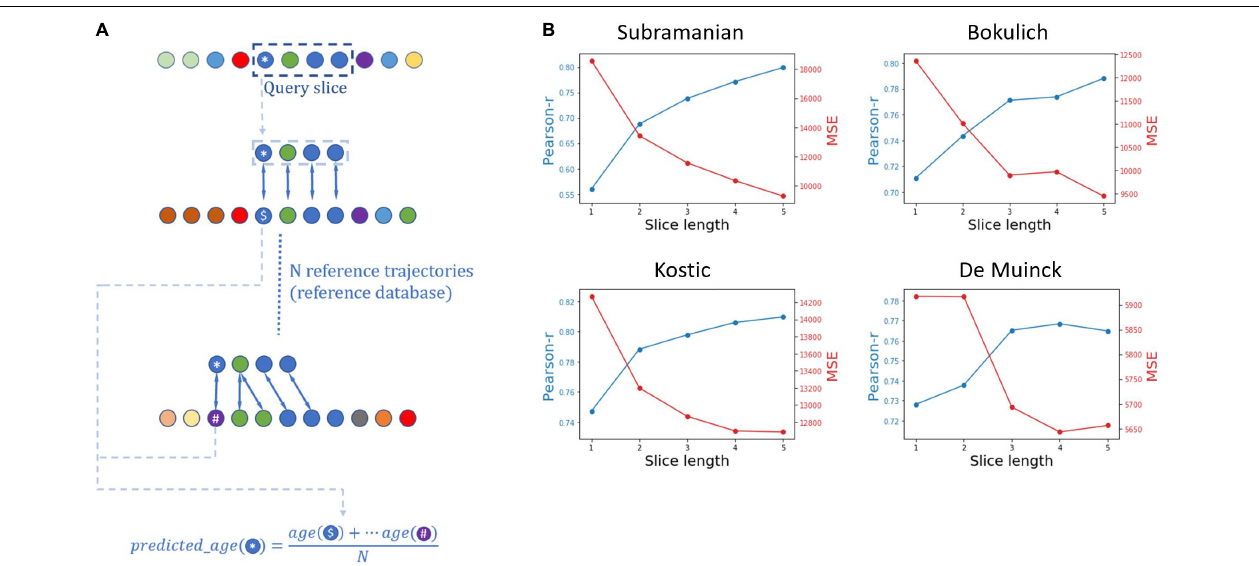
FIGURE 3 | Using microbiome temporal alignment for age prediction. (A) A schematic illustration of the age prediction framework for a 4-samples-long slice. The query in the age prediction framework is a slice from a trajectory, marked by the dashed box. The ages of samples in the query are assumed to be unknown, and for simplicity purposes the age prediction framework aims to predict the age of the first sample of the slice, marked by an asterisk. The local alignment between the query slice and each trajectory from a reference dataset is calculated, and the predicted age is then calculated as the mean age of the samples to which the query sample was aligned. (B) Results of the simulations evaluating the performance of alignment-based age prediction. Shown are the Pearson’s r values for the correlation between the predicted and real ages, alongside mean square error (MSE) values, for each slice length in the four datasets analyzed in our